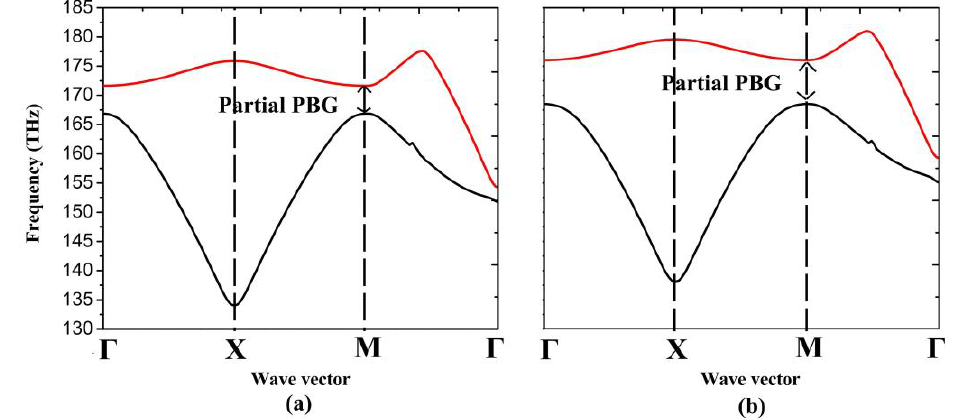
µ µ µ c1 = 0.6 eV, c2 = 0.8 eV; ( b ) c1 = 0.6 eV, c2 = 0.85